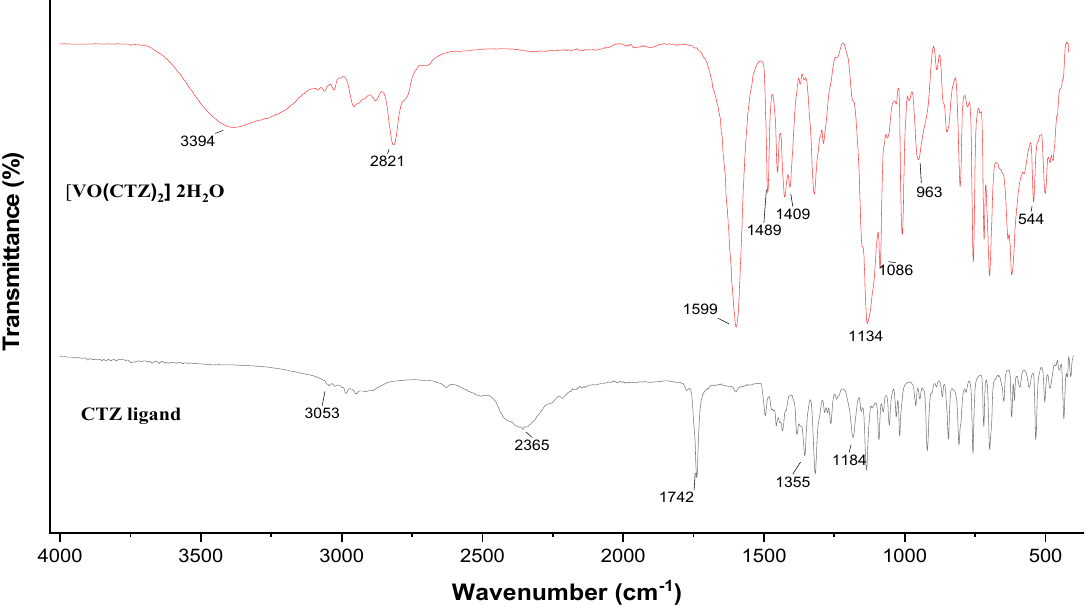
Figure 2. A comparison of the IR spectra of free CTZ ligand and its oxidovanadium(IV) complex in the range 4000–500 cm − 1 .